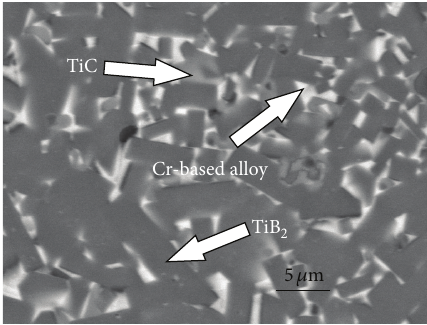
Figure 2: FESEM microstructure of the TiC-TiB 2 ceramic compos- ites.